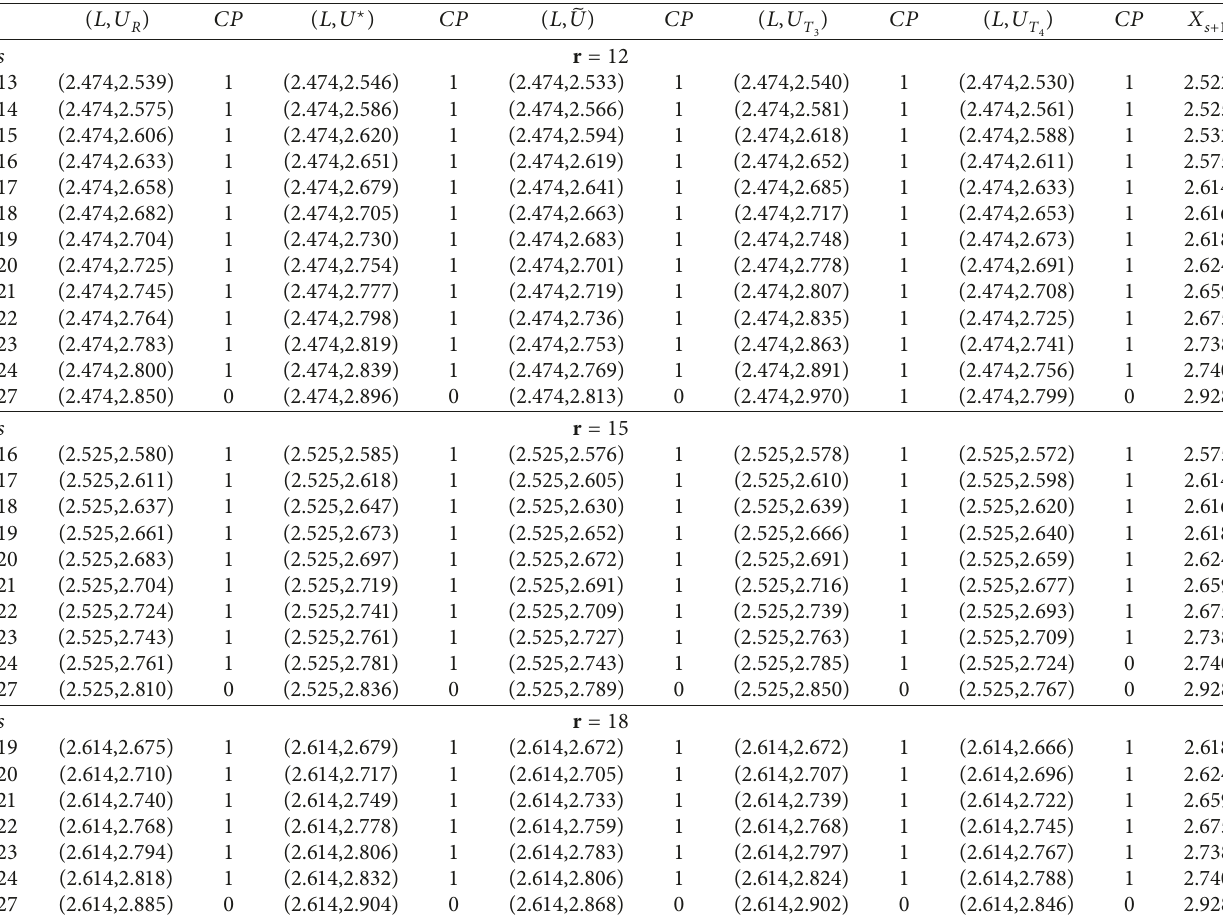
Table 7: Ninety five percentage predictive intervals of X � 1 . the choice x 0